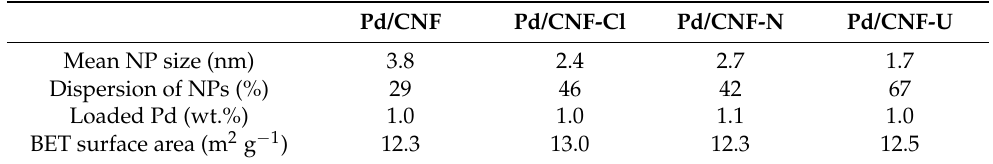
Table 1. Pd composition, BET surface area, mean NP sizes, and dispersion of NPs of the catalysts. Pd/CNF Pd/CNF-Cl Pd/CNF-N Pd/CNF-U Mean NP size (nm) Dispersion of NPs (%) Loaded Pd